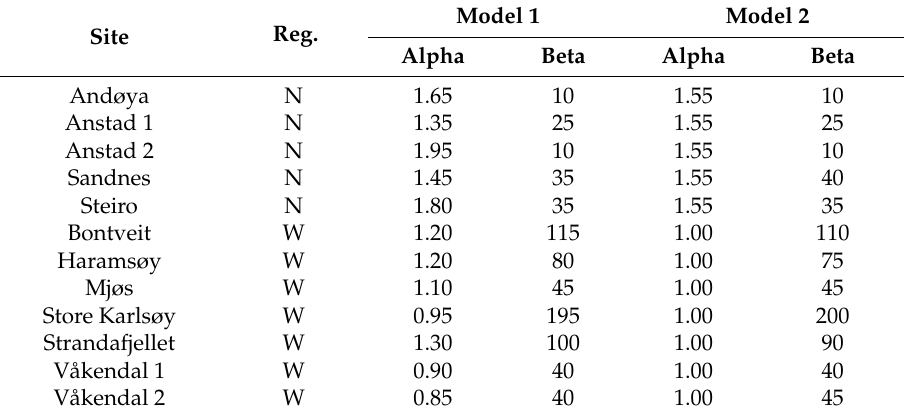
Table 4. Coefficients for alpha and beta for Model 1 and 2, spread distances. Model 2 with Alpha = 1 corresponds to a negative exponential model.